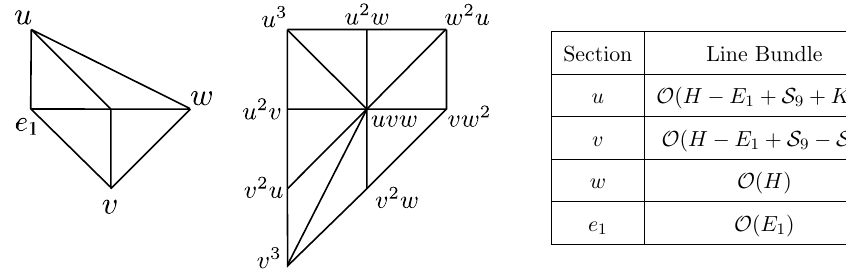
Figure 3 . The polytope F 3 and its dual. The table on the right provides the line bundle classes for the coordinates in P F 3